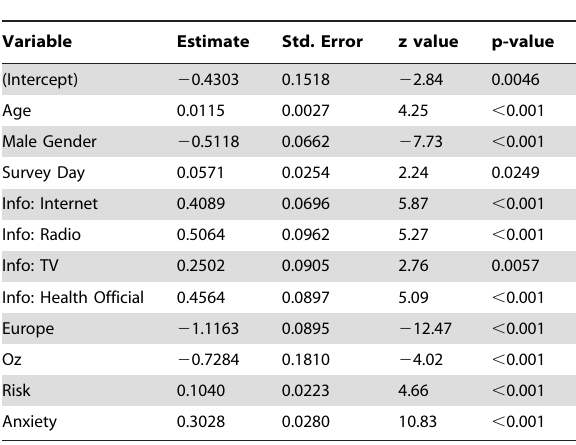
Variable definitions as in table 2.